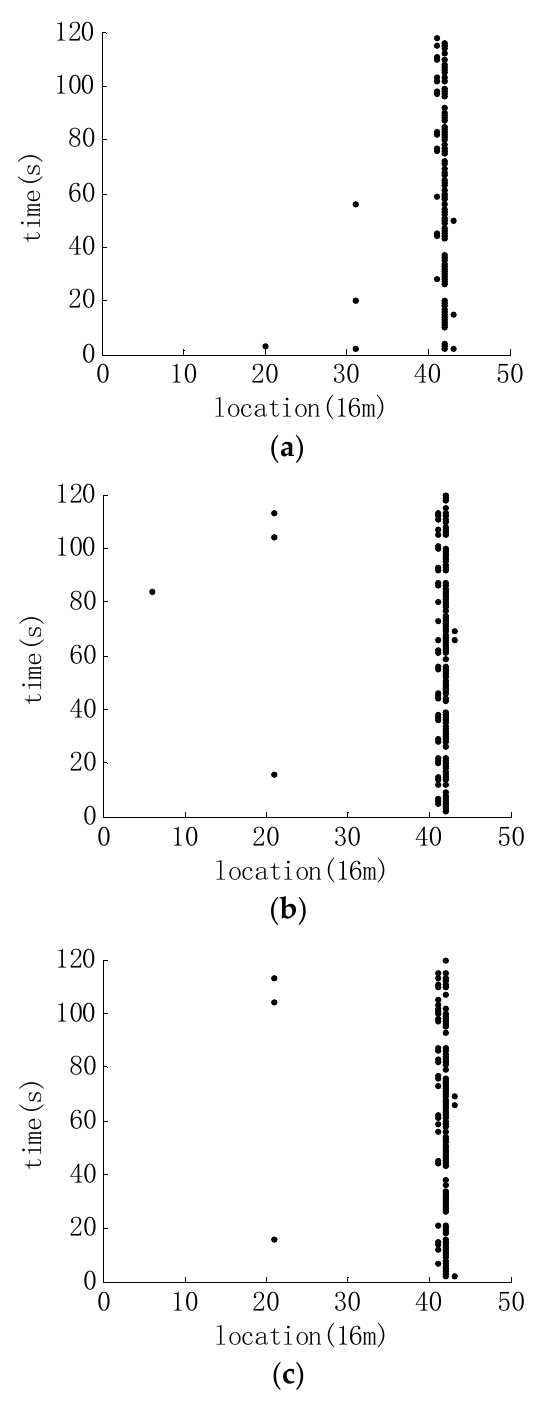
Figure 17. The detection results of walking signals. ( a ) The first group of walking signals; ( b ) The